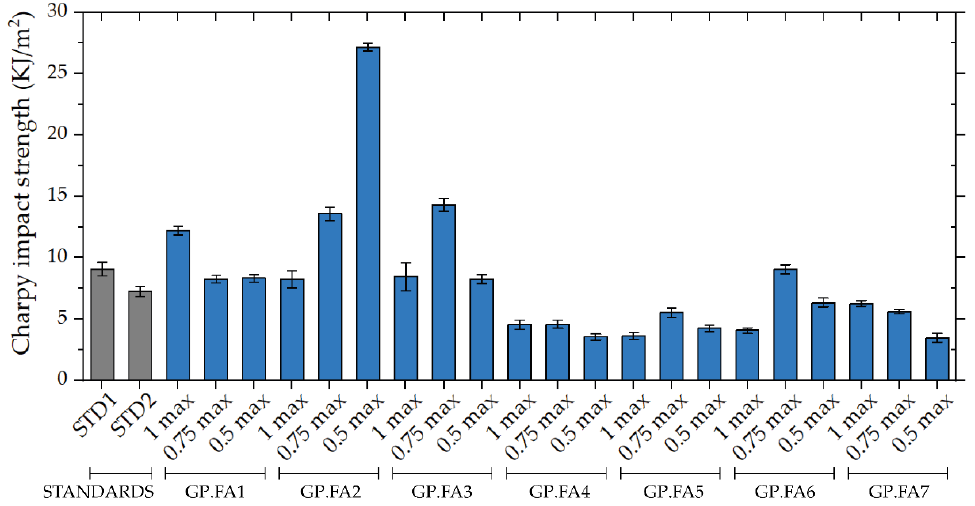
Figure 5. Charpy impact strength of geopolymers with FA1 – 7.